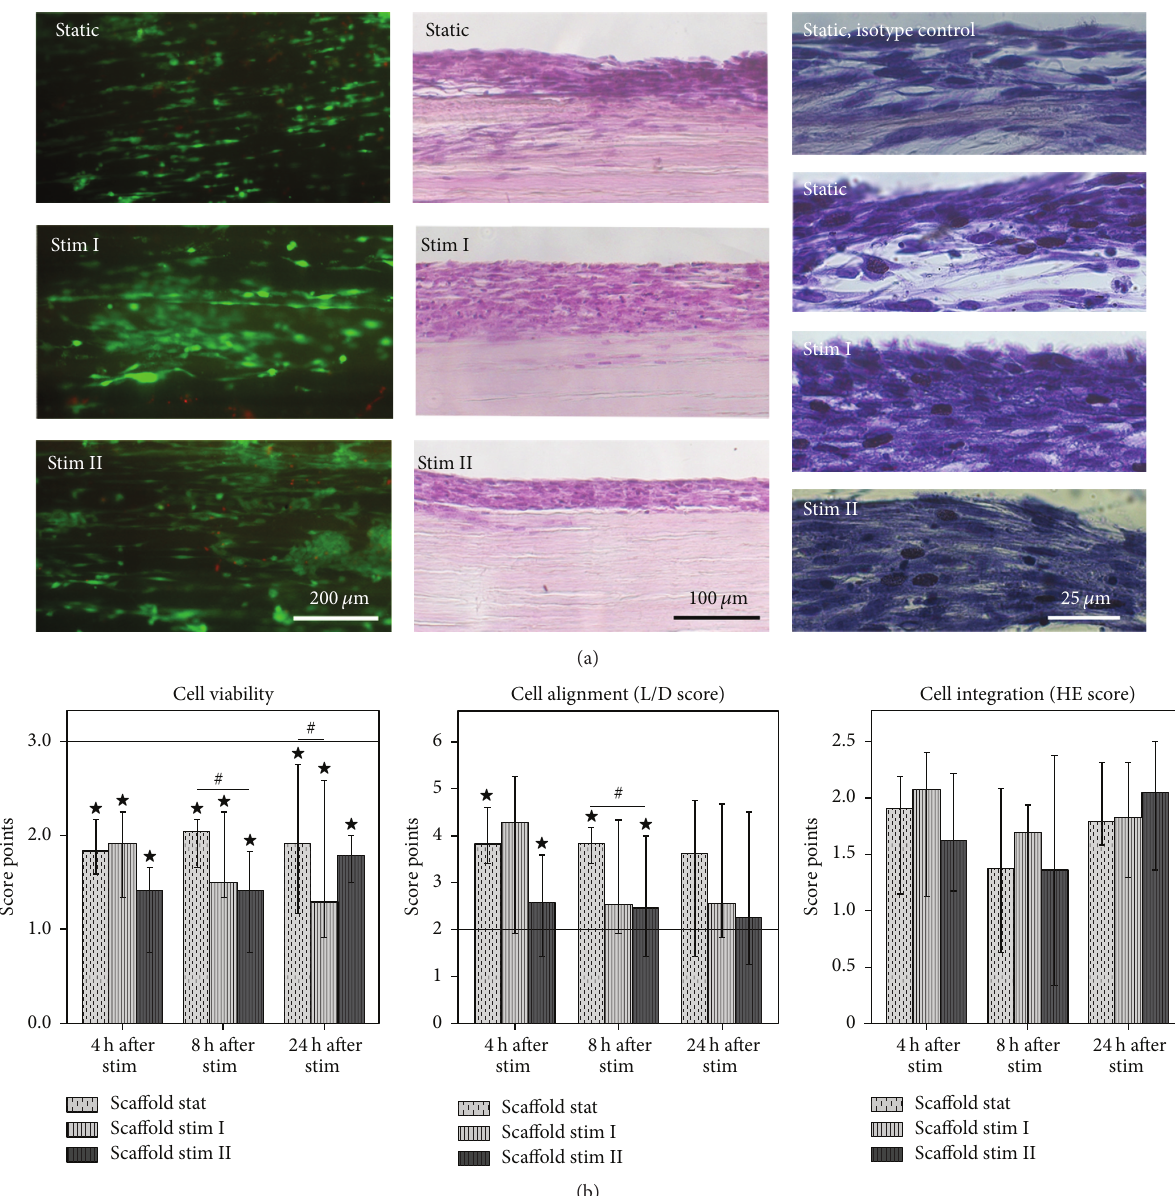
Figure 2: (a) Microphotographs of LIVE/DEAD (cid:3) staining of seeded scaffold samples (viable cells shown in green, dead cells in red; left), hematoxylin and eosin staining of paraffin sections (middle), and procollagen 3A1 immunostaining of paraffin sections (positive staining in dark brown; right), 24 h after mechanical stimulation. (b) Score points for cell viability (left) or cell morphology, alignment, and distribution on the scaffold surface (L/D score; middle), obtained by evaluation of LIVE/DEAD stained samples, the horizontal lines representing the monolayer controls, and score points for cell integration and cell layer integrity (HE score, right), obtained by evaluation of hematoxylin and eosin stained sections; bars represent the median values and error bars the 95% confidence interval; ⋆ marks significant differences compared to the monolayer control ( 𝑝 < 0.05 ); # means significant differences between the sample groups indicated ( 𝑝 < 0.05 ); stat: static; stim: mechanical